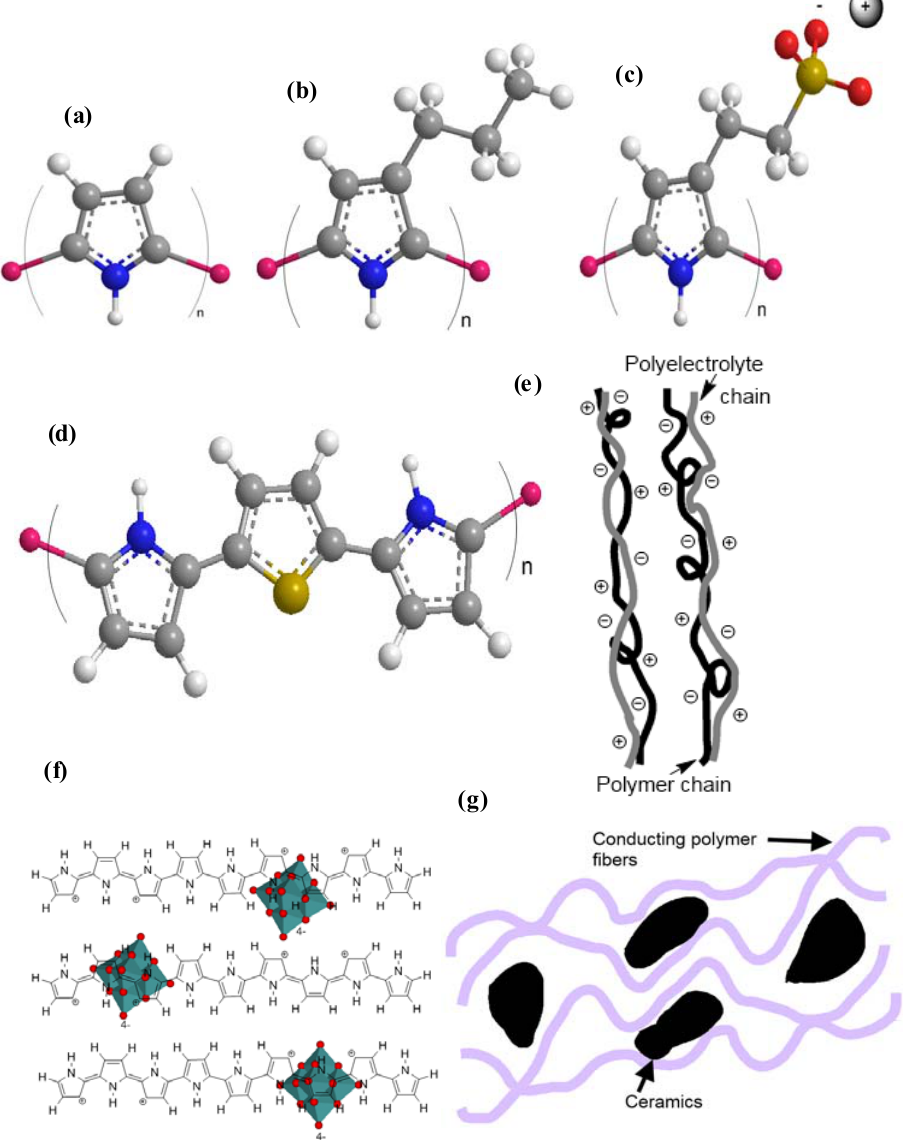
Figure 2. Classification of conducting polymers, (a) Basic conducting polymer, (b) substituted polymer, (c) self-doped polymer, (d) copolymer, (e) blend, (f) hybrid material and (g)